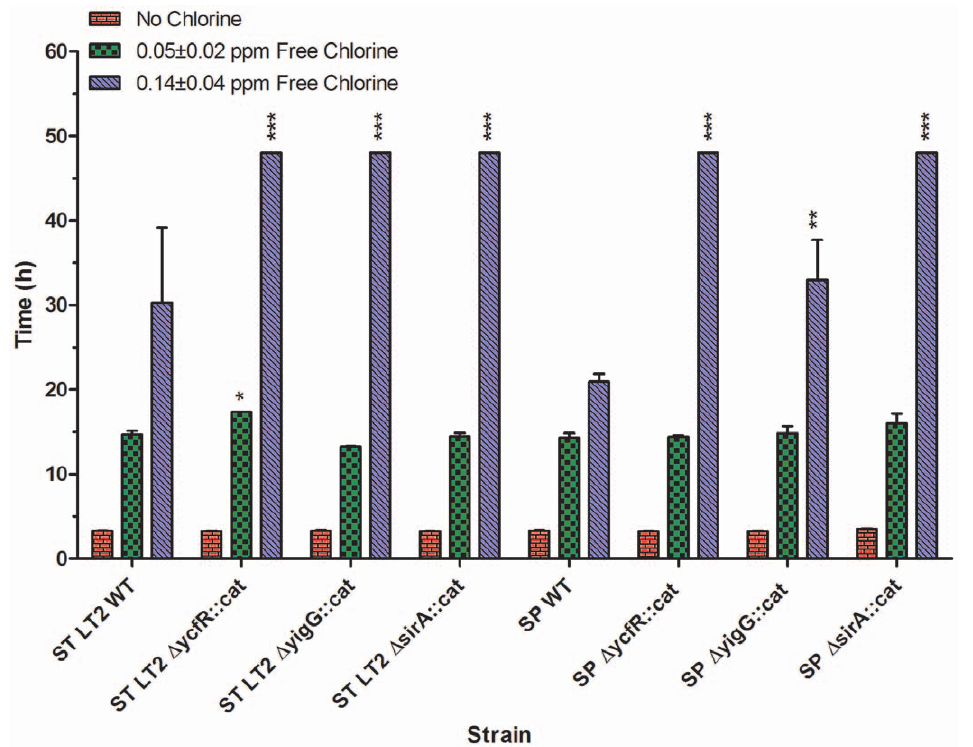
Figure 2. Extended lag phase of S.enterica wild-types and mutants in BIH broth with and without chlorine stress. Standard deviations represent three independent experiments. Significant differences in comparison to the parent strains under the same experimental condition are shown as *( P , 0.5), **( P , 0.001), and ***( P , 0.0001).